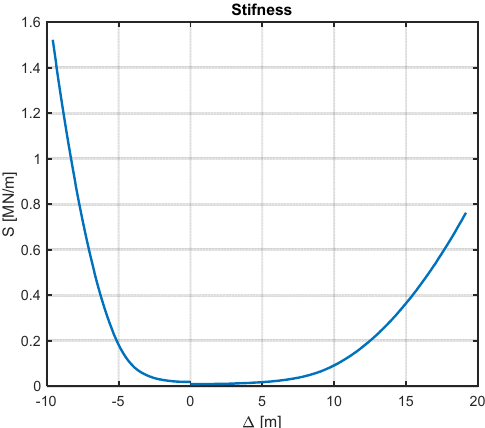
Figure 15. Horizontal stiffness as a function of the excursion ( Δ ), Case 1, pre-tension 30 kN, minimum diameter.